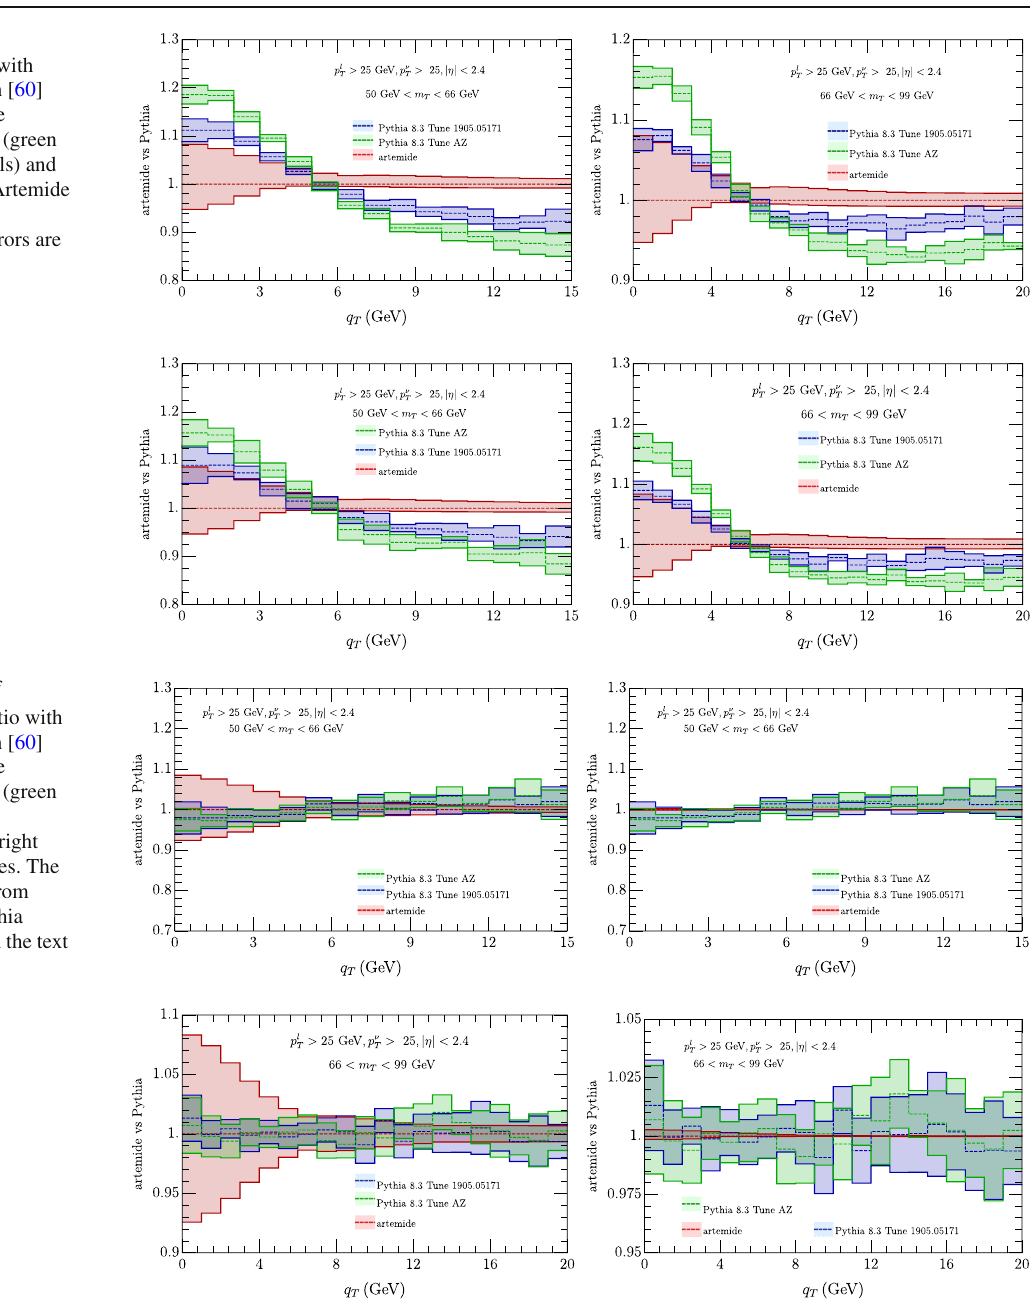
Fig. 10 Comparison of + / p W − Artemide p W ratio with T T Pythia 8.3 AZ tune as in [60] (blue band) and as in the original ATLAS release (green band). Left panels show uncorrelated errors and right panels the correlated ones. The Artemide error comes from scale variations, the Pythia errors are commented in the